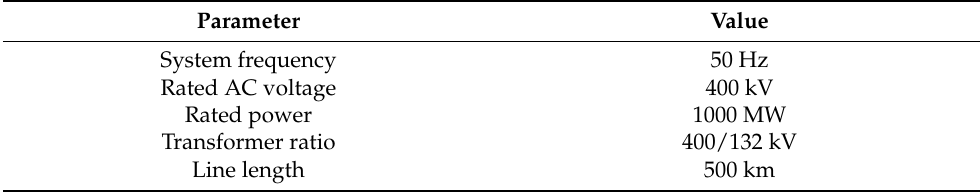
Figure 5. The Iraqi super grid: ( a ) single line diagram; ( b ) geographical overview. Table 2. Model specification of case